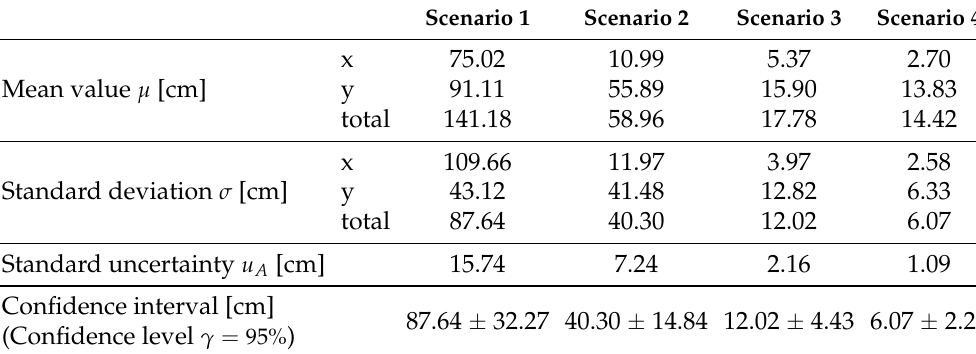
Figure 12. Data visualization scenario 4: Four lines of sight in a free environment. Table 3. Comparison of the